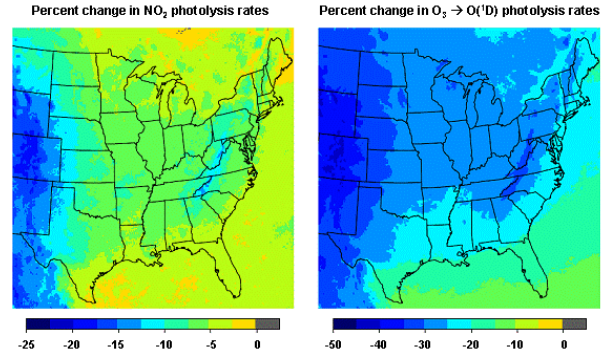
Fig. 9. Percent change in monthly averaged photolysis rates over daytime hours (14:00–24:00Z) for NO 2 (left) and O 3 → O( 1 D)